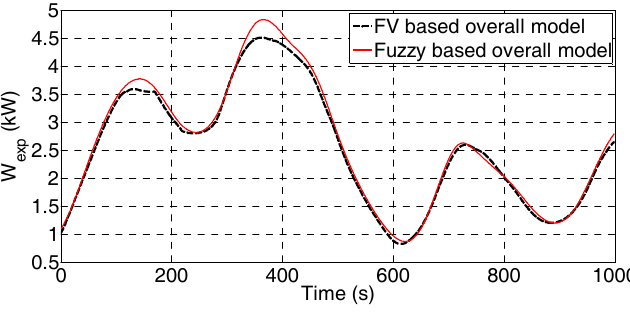
Figure 17. Prediction of expander power output with the fuzzy and FV evaporator-based overall models.